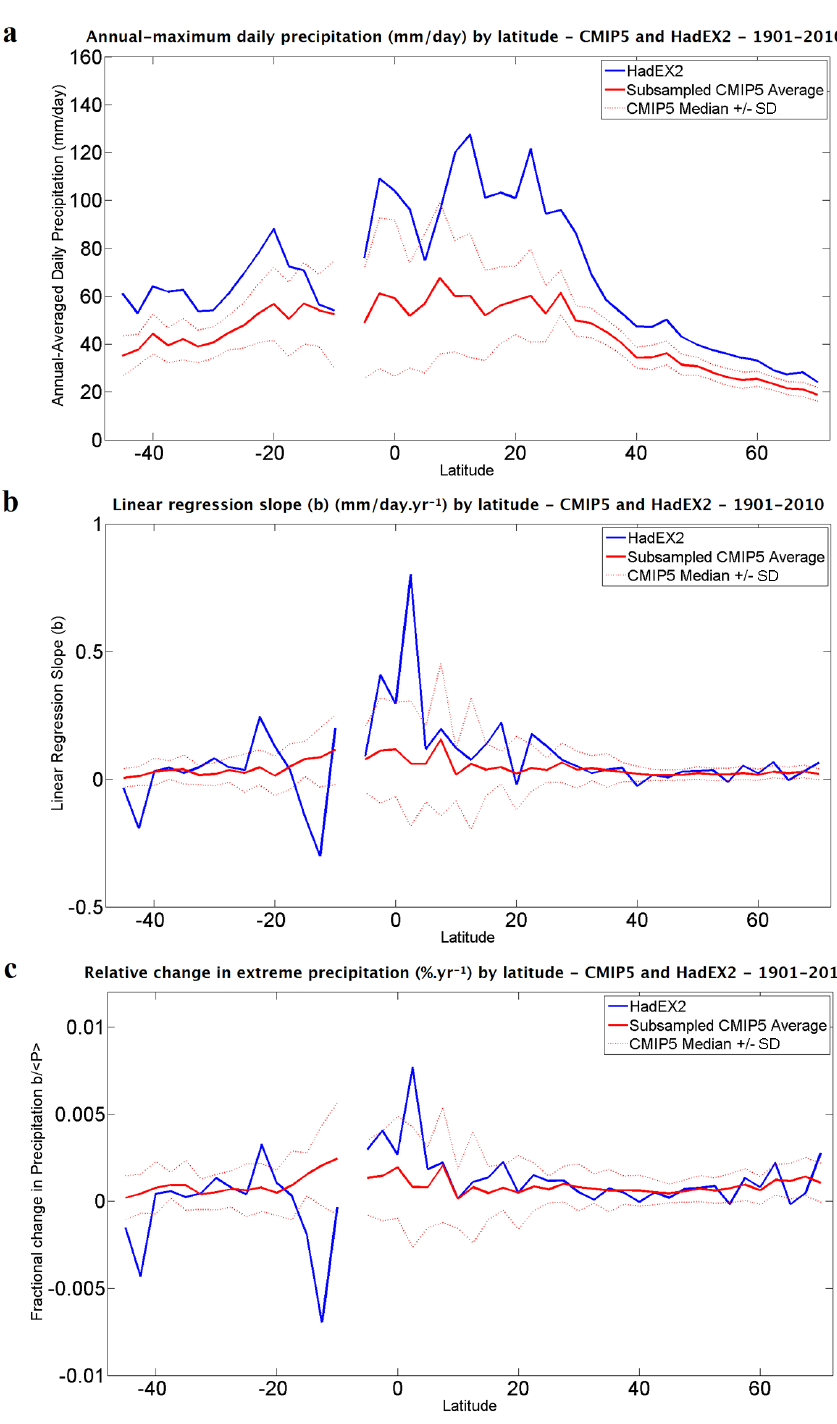
Figure 6. Average parameter value at each 2.5 ◦ latitudinal window – (a) annual-maximum daily precipitation (mmday − 1 ) for HadEX2 and average CMIP5, (b) slope of change in annual-maximum daily extreme precipitation (mmday − 1 yr − 1 ) for HadEX2 and average CMIP5, and (c) relative change in extreme precipitation (%yr − 1 ) for HadEX2 and average CMIP5. Values for the climate models are averages of the 19 runs and the dashed lines are the medians of the models plus/minus the standard deviation of the models. The gap in the tropics indicates the lack of grid cells with more than 30 years of precipitation data available in those